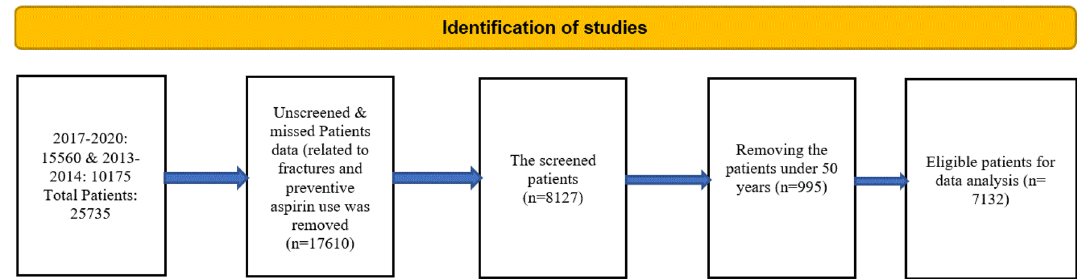
Figure 1. Flow chart of the included patients from the National Health and Nutrition Examination Survey (NHANES) database within 2013–2104 and